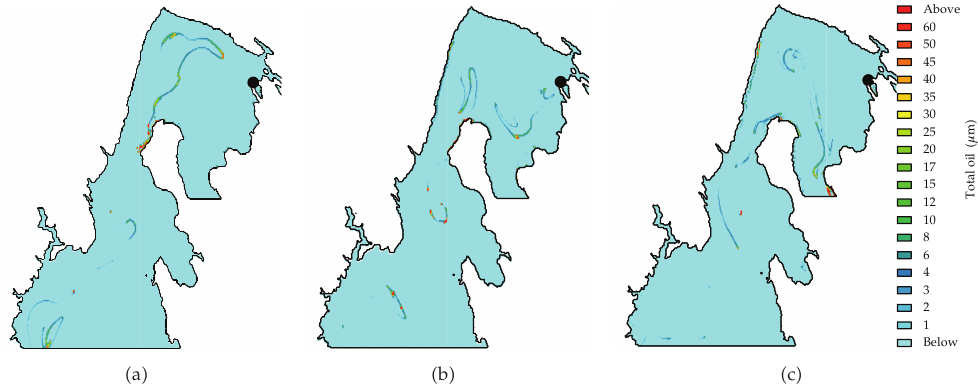
Figure 13: Oil pollution clouds for the 108th (cid:4) a (cid:5) , 150th (cid:4) b (cid:5) , and 192nd (cid:4) c (cid:5) hours after the spill onset at the position 3 (cid:4) entrance to the Omiˇsalj terminal—black rectangle (cid:5) in the summer period (cid:4) 21/7/08–31/7/08 (cid:5) .